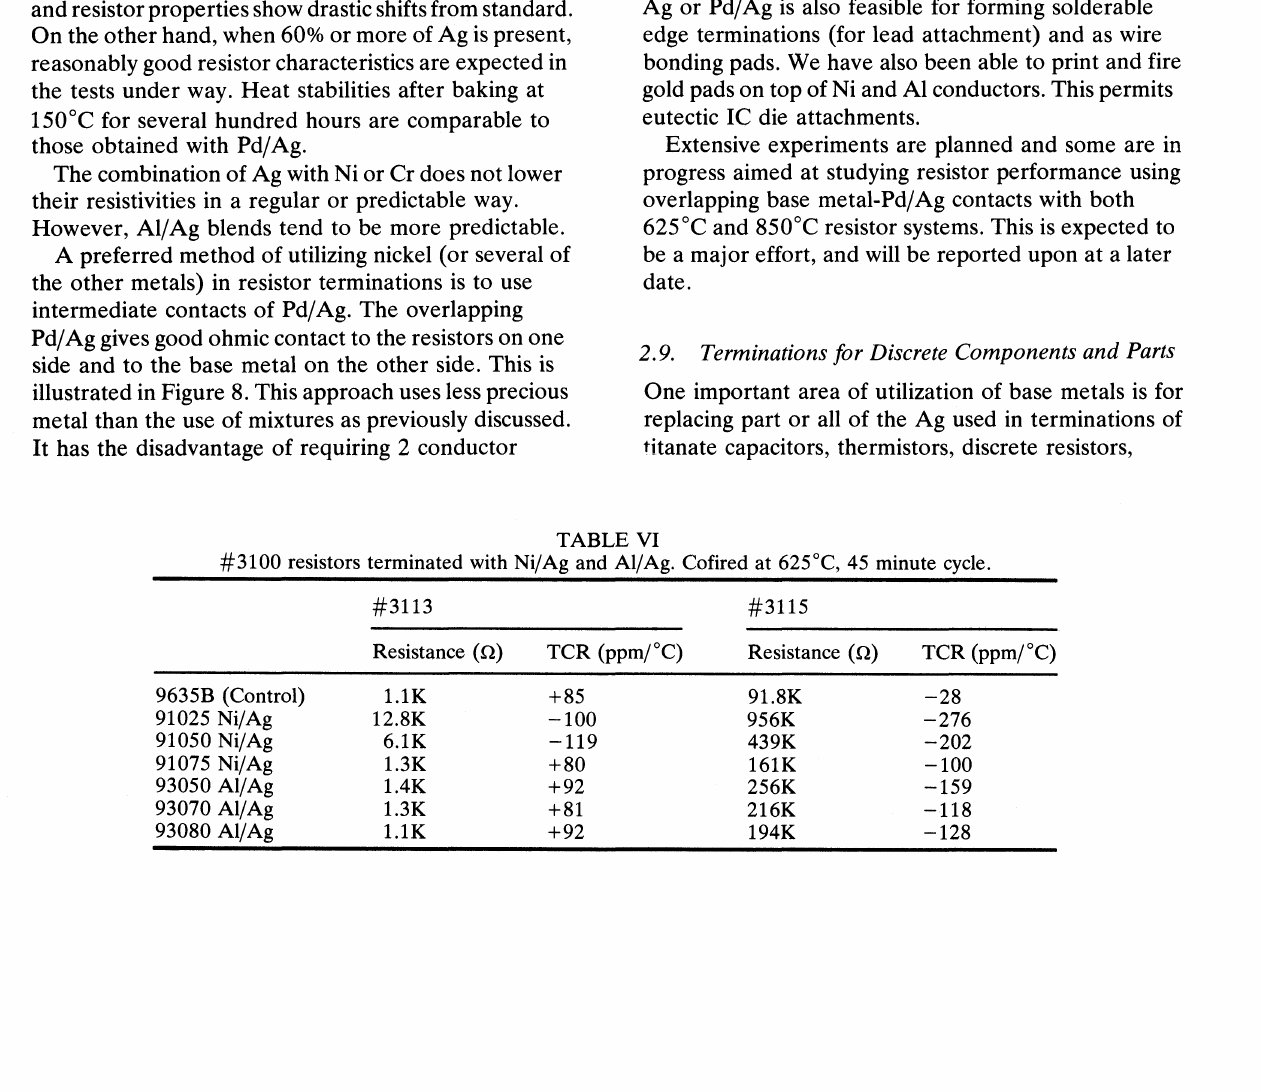
FIGURE 8 Resistor with overlapping